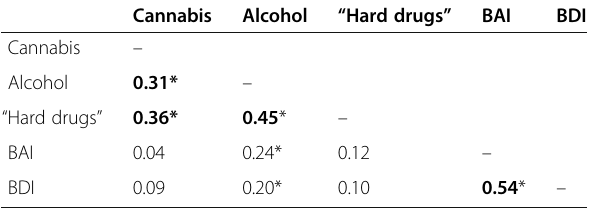
Table 4 Pearson ’ s correlation coefficient for BDI, BAI, and antecedent drug use of cannabis, alcohol, and “ hard drugs